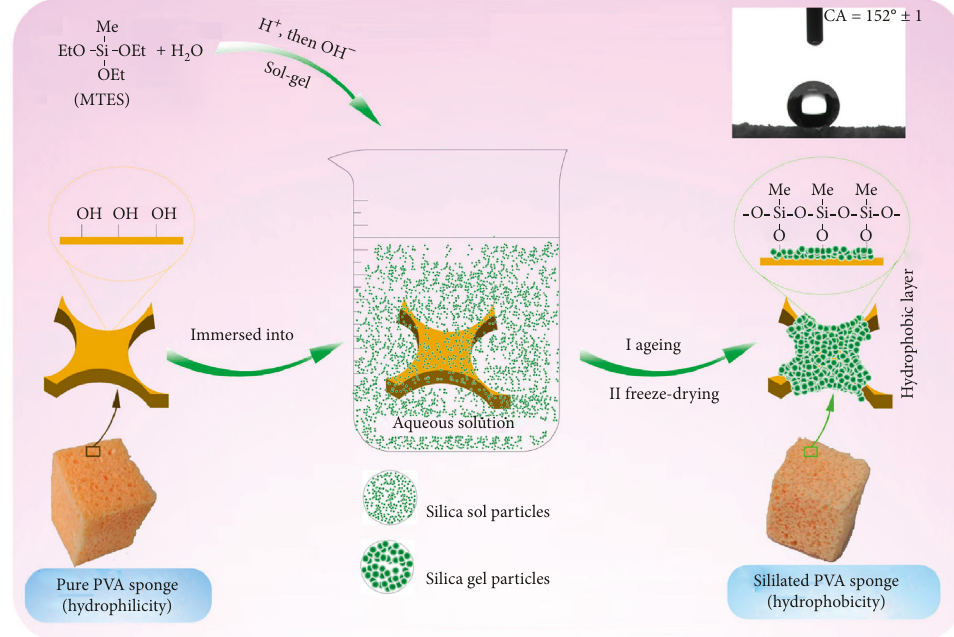
Figure 1: Schematic illustration of preparing the silylated PVA sponge by one-pot method.